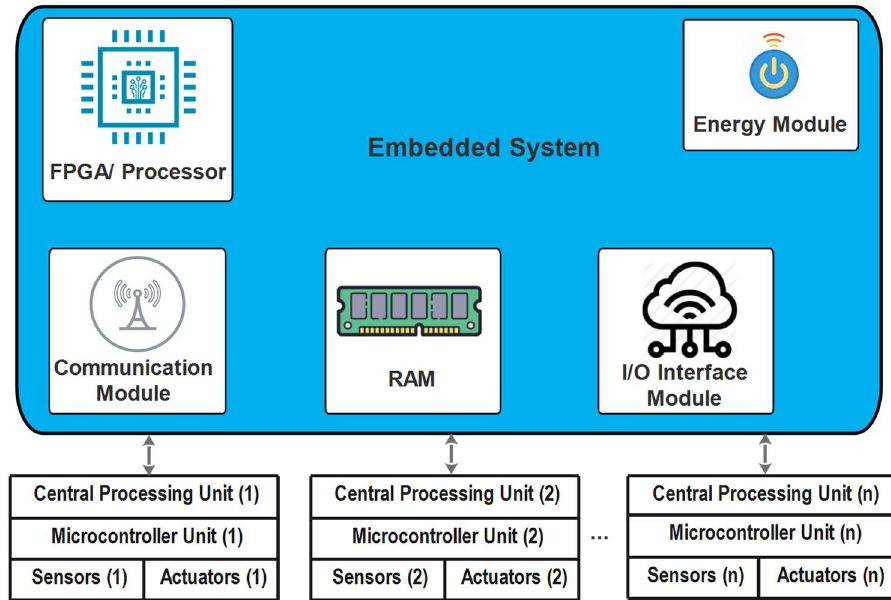
Figure 3. An illustration of the common architecture of an IoT device.